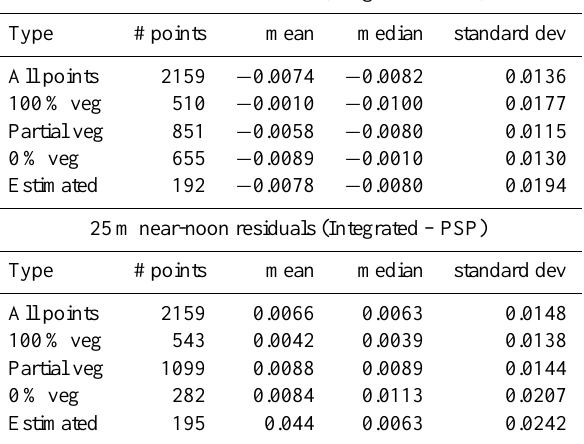
Table 3. Mean, median, and standard deviation of differences be- tween broadband albedo values calculated from integrating spectral albedo or measured from the